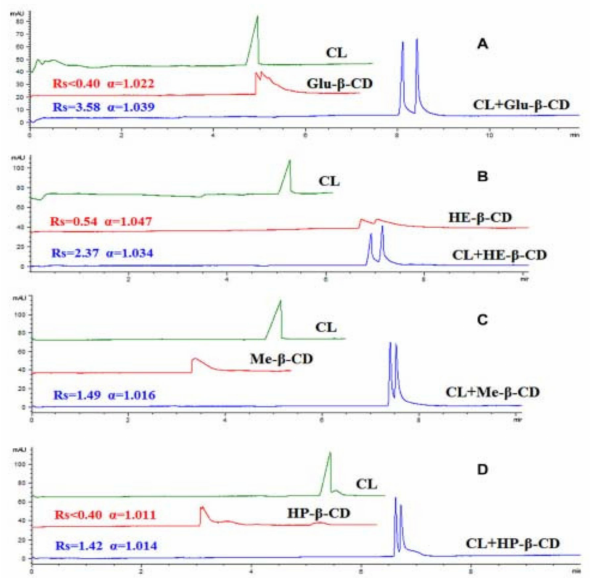
Figure 8. Enatio-separation of nefopam in single and dual CS systems (CL—clarithromycin, Glu- β -CD—glucose- β -CD, HE- β -CD—hydroxyethyl- β -CD, Me- β -CD—methyl- β -cyclodextrin, HP- β - CD—hydroxypropyl- β -CD) (CL concentration 50 mM, Glu- β -CD concentration 40 mM, HE- β -CD concentration 20 mM, Me- β -CD concentration 20 mM, HP- β -CD concentration 15 mM). ( A )CL + Glu- β -CD; ( B ) CL + HE- β -CD; ( C ) CL + Me- β -CD; ( D ) CL + HP- β -CD. The figure is reproduced from Yu et al. [60] with permission from